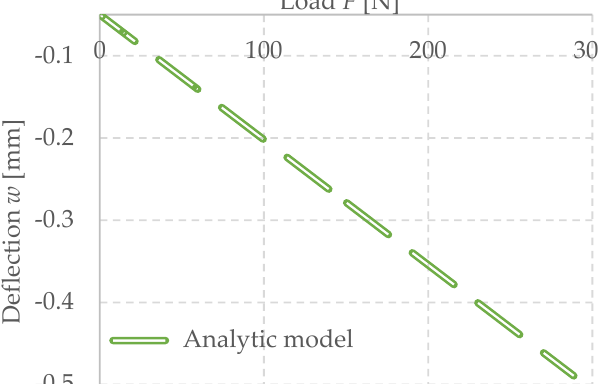
Figure 9. Schematic of the analytical load test used. Table 2. Selected material characteristics of foam concrete [1 – 6] .